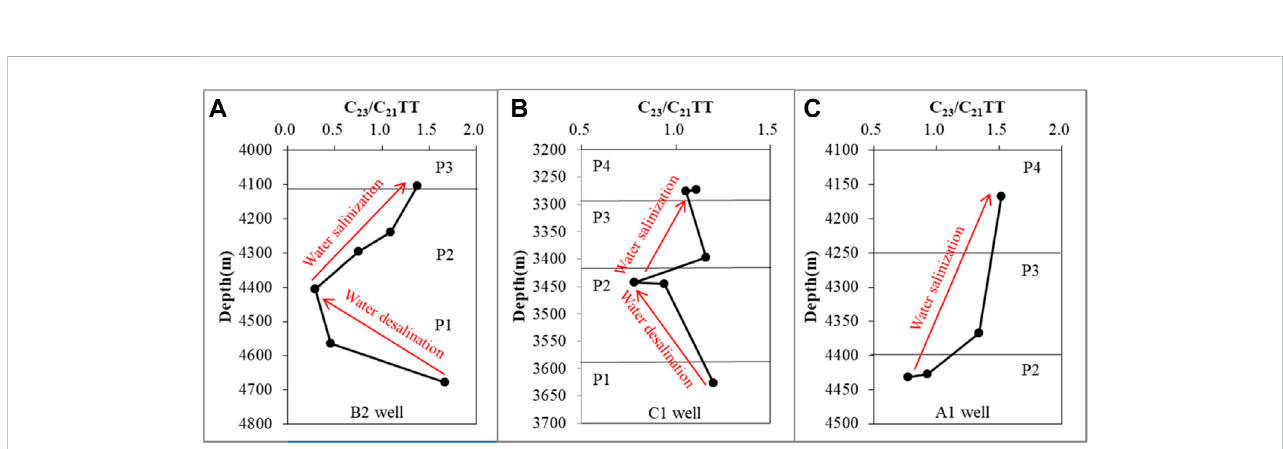
The pro fi le of C 23 /C 21 TT ratios along depths for the rock samples in the B2 (A) , C1 (B) and A1 (C) wells. The C 23 /C 21 TT ratios in these three wells vary synchronously along